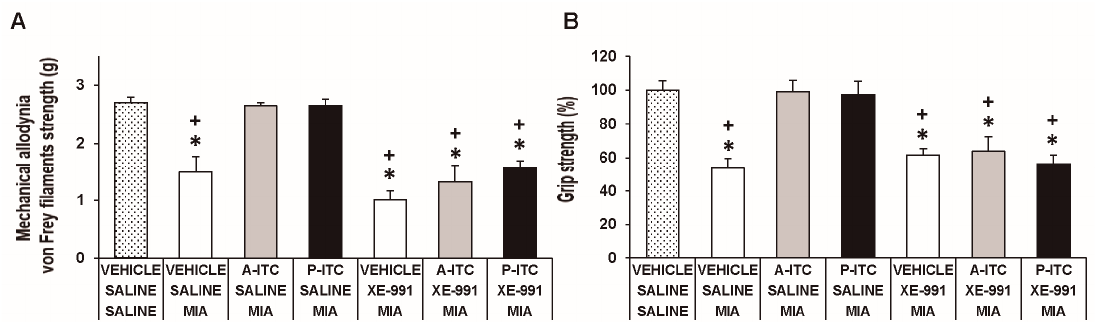
Figure 5. The administration of XE-991 reverses the inhibition of the mechanical allodynia and grip strength deficits of A-ITC and P-ITC during chronic osteoarthritis pain. The mechanical allodynia in the ipsilateral paw ( A ) and grip strength deficits in the hind paws ( B ) of the MIA-injected mice